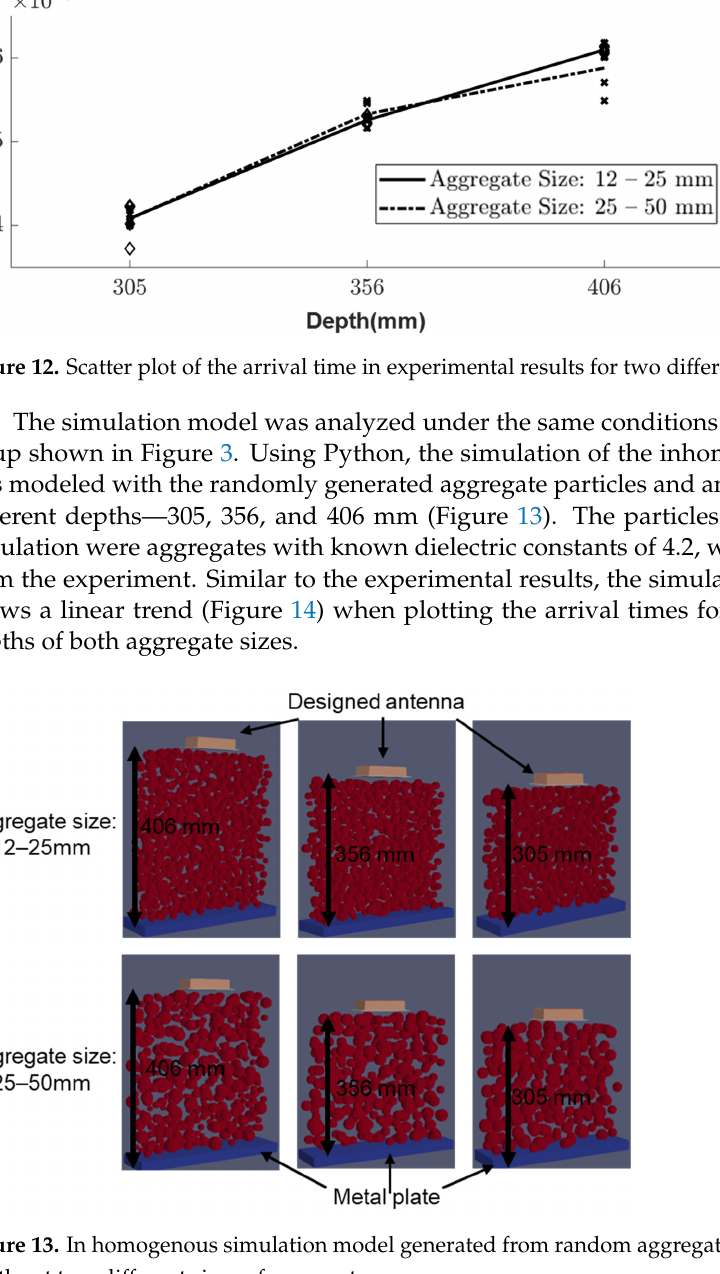
Figure 14. Sca tt er plot of the arrival time in simulation results for two di ff erent sizes of aggregates . In comparing the results of the random particle simulation and the experimental study for the di ff erent sizes of aggregates, a similar trend is observed, but there is a delay in the arrival time at each depth due to the random distribution of the aggregate models and variable sizes (Figure 15). However, the simulation considers all the aggregates as spheres, which may not accurately represent the irregular shapes of the real aggregates. Therefore, further research is needed to study the inhomogeneous random aggregate pat- terns with irregular sizes to improve the accuracy of the simulation.